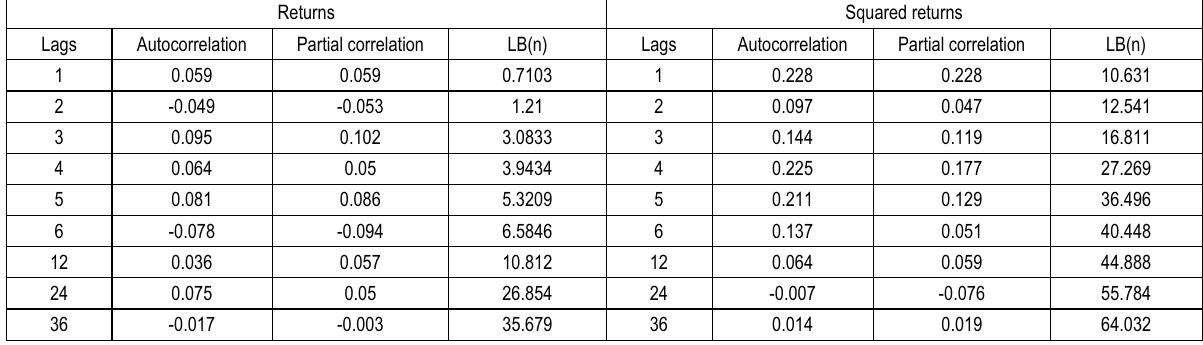
Table 2. Test for serial dependence in first and second moments of DJSIUS series